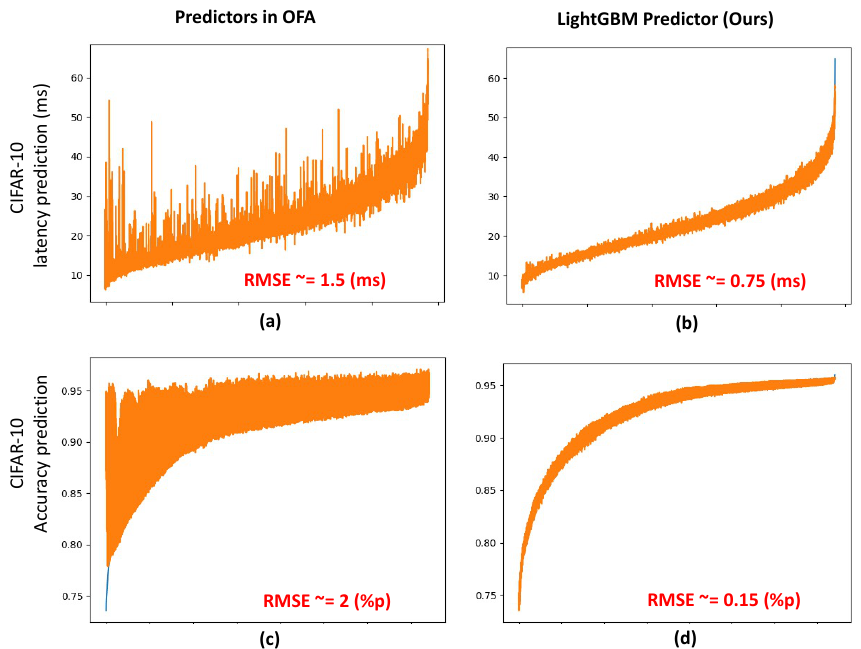
Figure 6. Accuracy and latency prediction comparison: ( a ) MLP model for latency prediction, ( b ) LightGBM model for latency prediction in CondNAS, ( c ) MLP model for accuracy prediction in OFA, and ( d ) LightGBM model for accuracy prediction in